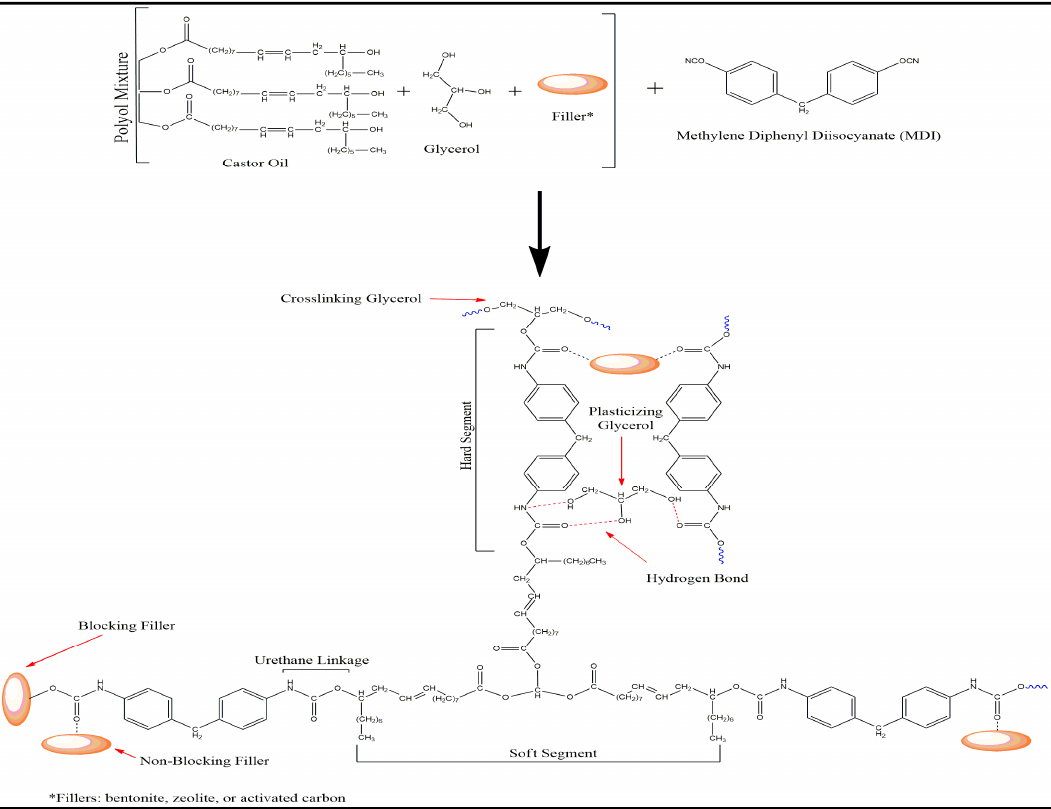
Figure 1. The reaction of castor oil-based PUF via the one-shoot method with the addition of glycerol and fillers.